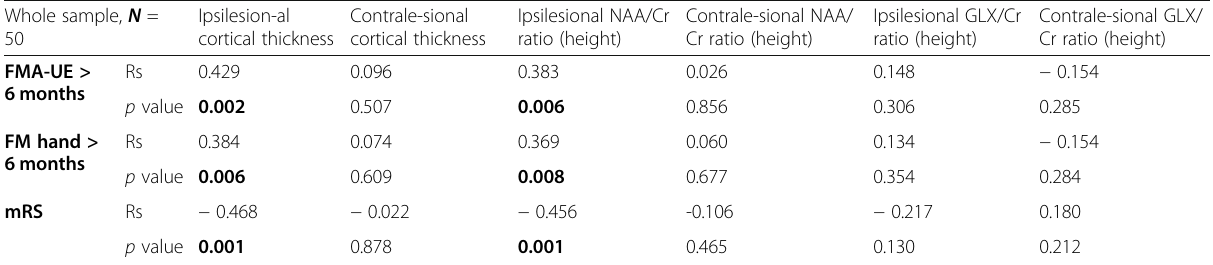
Table 3 Correlation of cortical thickness and metabolites ratios with mRS, FMA-UE, and FMA of the hand Whole sample, N = 50